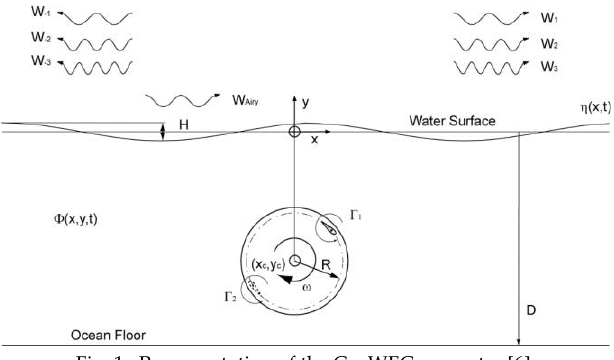
Fig. 1. Representation of the CycWEC geometry